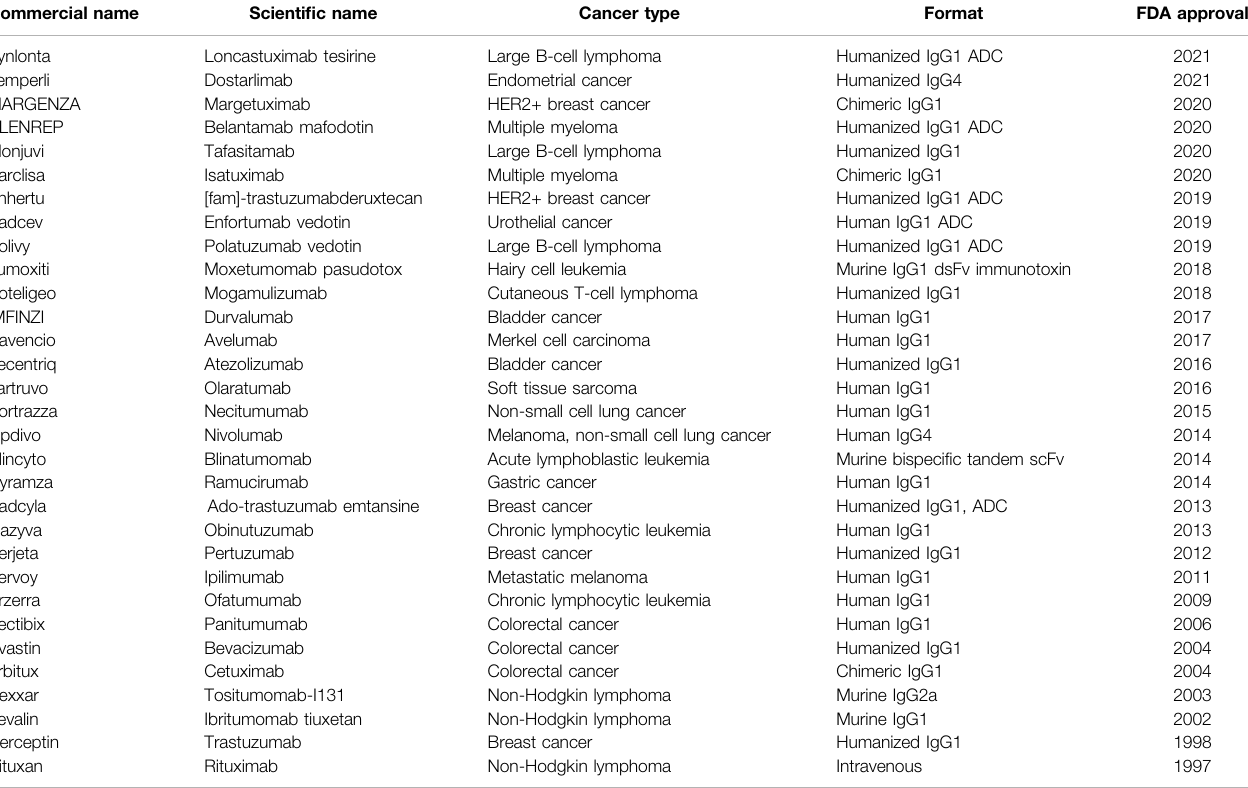
TABLE 1 | List of existing FDA-approved monoclonal antibodies for cancer treatment. (Reichert, 2012; Ecker et al., 2015; Reichert, 2016; Reichert, 2017; Kaplon and Reichert, 2018; Kaplon and Reichert, 2019; Kaplon et al., 2020; Kaplon and Reichert,